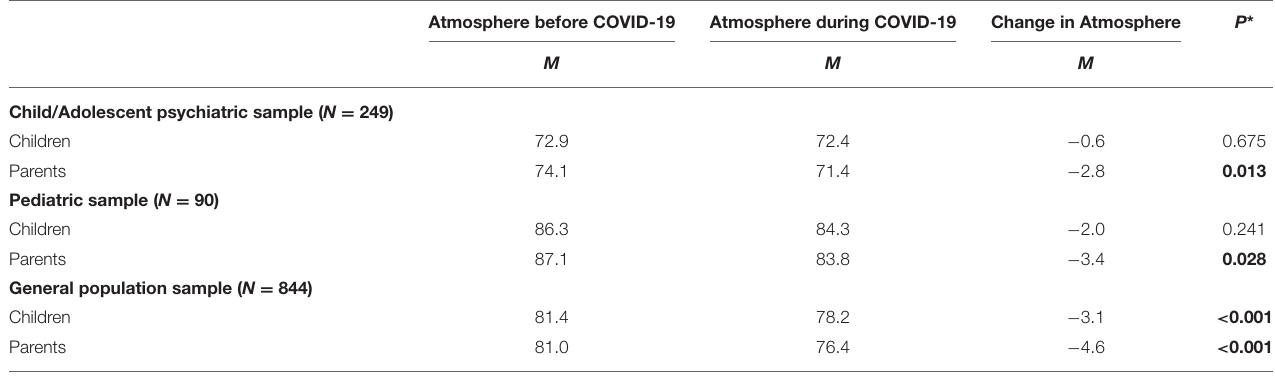
TABLE 4 | Atmosphere at home as experienced by children and parents.